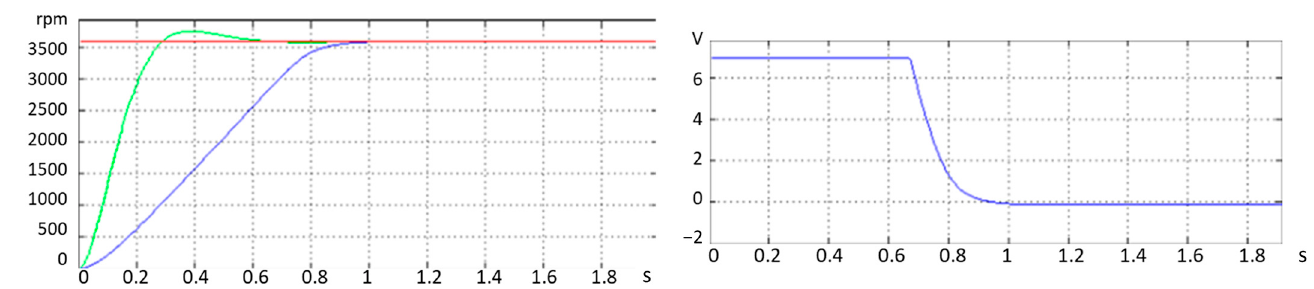
Figure 4. Simulation of the control system.